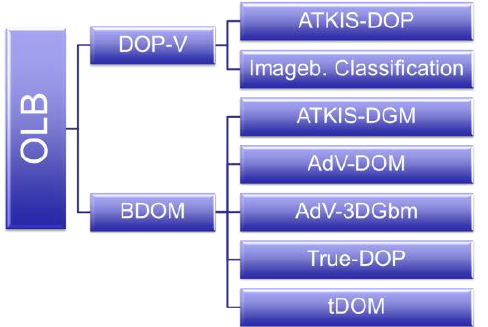
Figure 5: Product chain based on orientated aerial photos These so called official basic geodatasets (Amtliche Geobasisdaten) are used in a lot of technical applications at